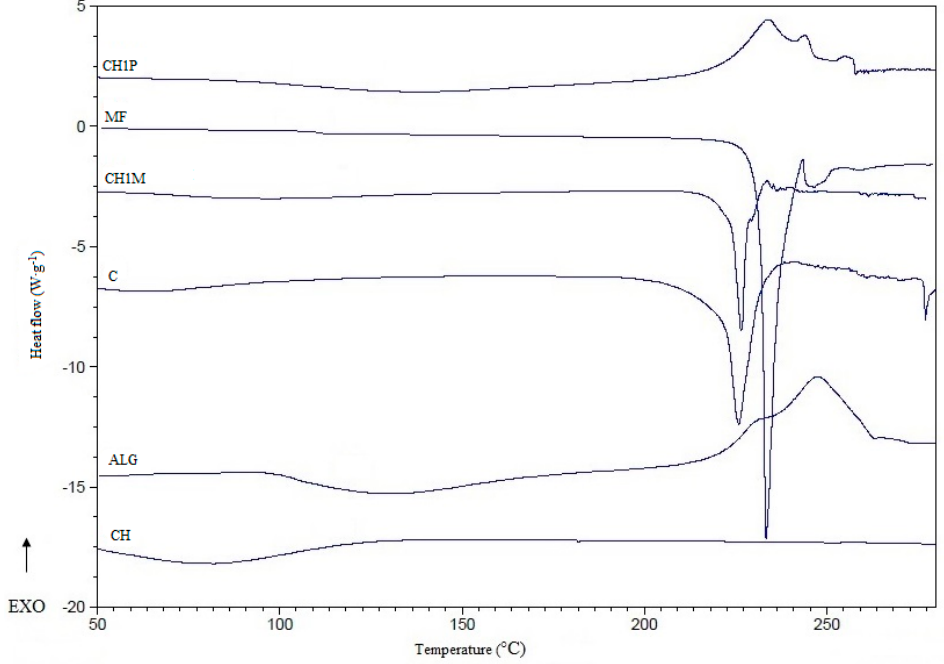
Figure 4. DSC thermograms of sodium alginate (ALG), pure metformin hydrochloride (MF), non cross-linked microparticles formulation C, chitosan (CH), cross-linked microparticles placebo (CH1P) and cross-linked microparticles formulation CH1M.